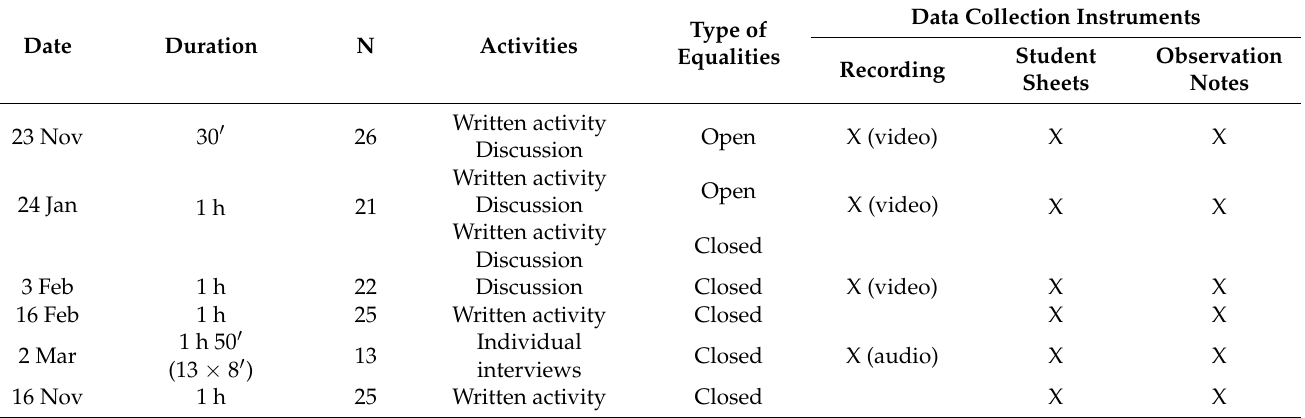
Table 1. General Characteristics of the Classroom